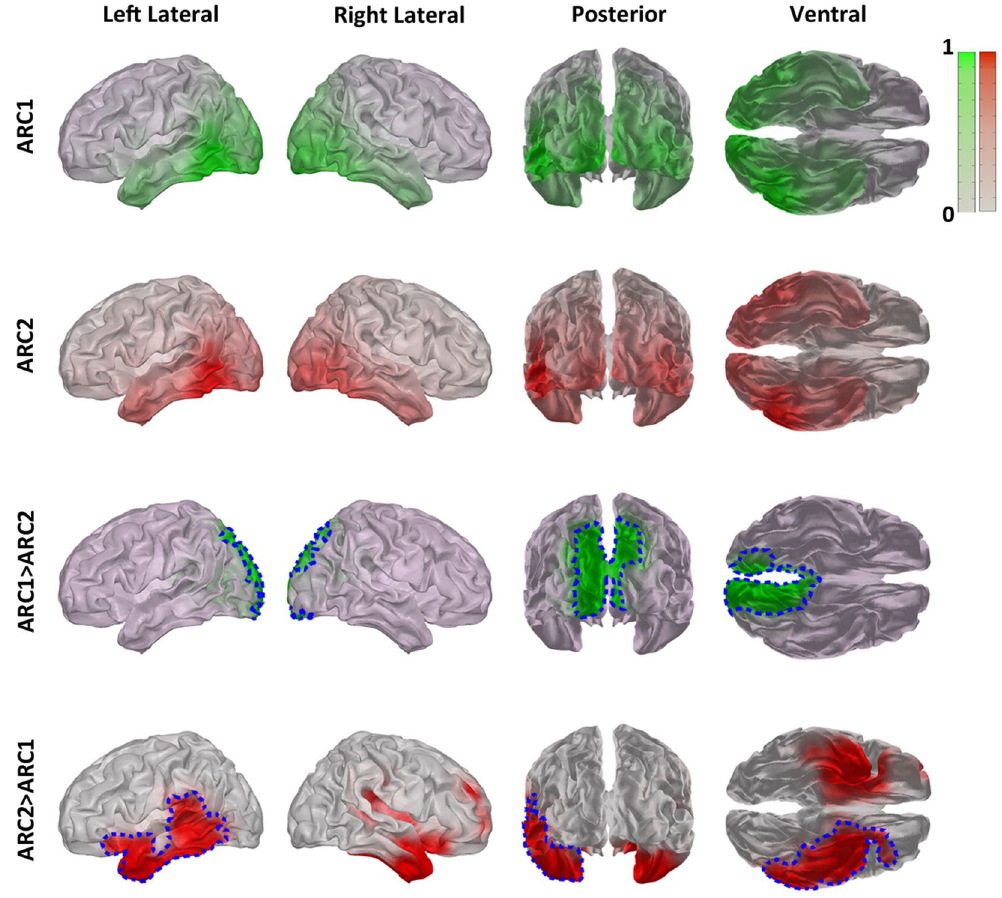
Figure 5. Group level statistics shows different sources of alpha rhythm components. Top row: Normalized group-averaged spatial loadings of ARC1 rendered on the average MNI brain are shown in four views. Second row: Normalized group-averaged spatial loadings of ARC2. Third and fourth (bottom) rows represent the results of uncorrected t-test and cluster-based permutation test. The green color shows the regions where ARC1 has significantly higher loadings than ARC2 (uncorrected), whereas the red cluster shows the locations where ARC2 has significantly higher loadings than ARC1 (uncorrected). The areas bordered by dotted blue line indicate significant clusters that survived correction for multiple comparisons. See Results for